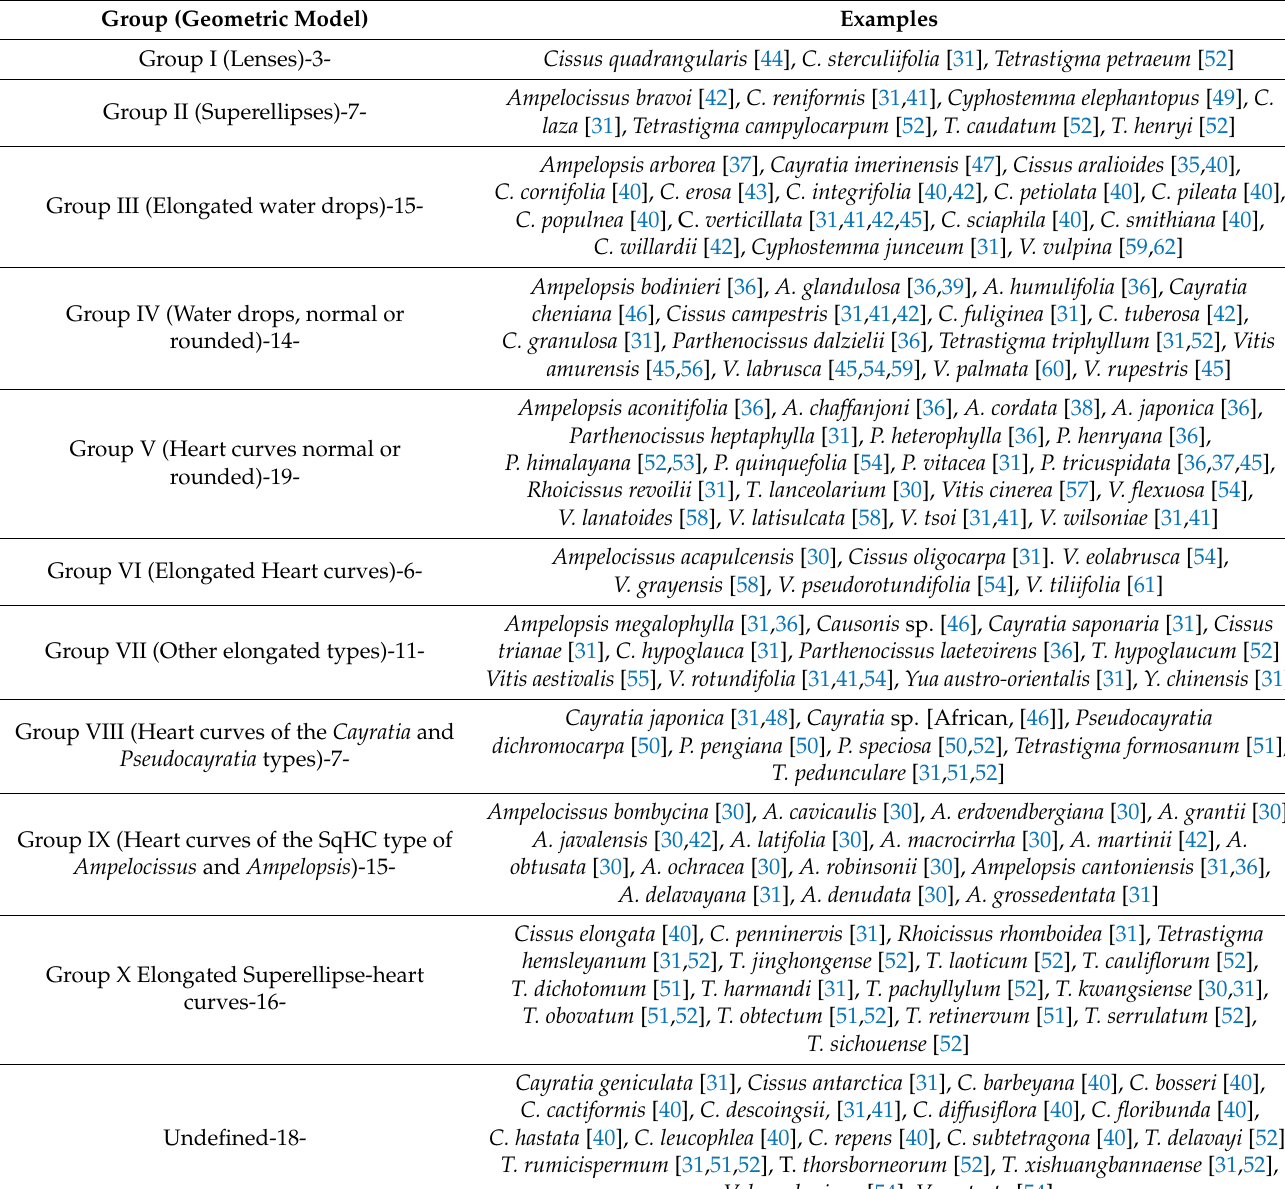
Table 3. A summary of groups based on morphological seed types for the analysed species in the Vitaceae. The number of cases found in each group is given between